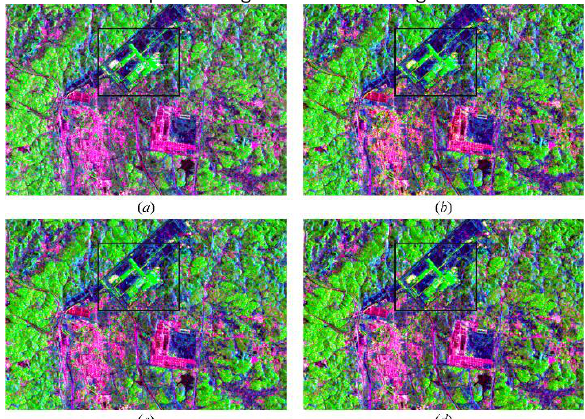
Figure 3. The RGB image color coded by red: double-bounce, green: volume scattering, blue: odd-bounce, from the four methods. ( a ) the new method; ( b ) Y4R; ( c ) S4R; ( d ) G4U.